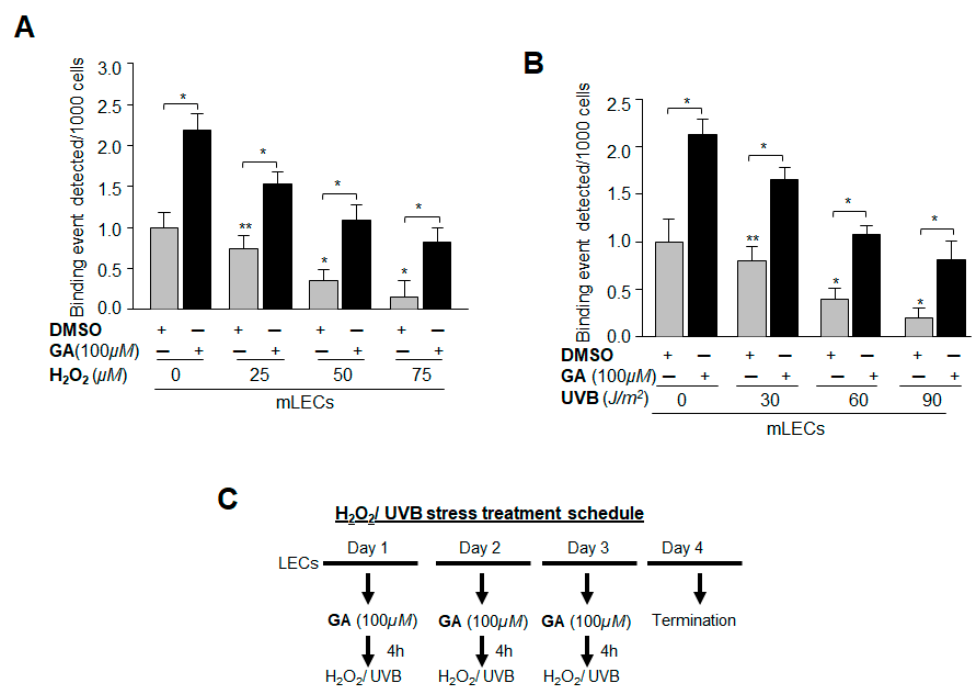
Figure 9. GA significantly promoted Sp1 binding to its element present in Prdx6 promoter by abating oxidative stress and aberrant Sumoylation signaling. ( A , B ) mLECs were treated with Sumoylation inhibitor GA. The cells were washed and exposed 4 h later to different concentrations of H 2 O 2 ( A ) or UVB ( B ) as indicated. Similarly, treatment was repeated on day two and day three. A ChIP assay was carried out 72 h later, using a ChIP grade anti-Sp1 antibody. The DNA fragments were used as templates for qPCR by using a primer designed to amplify − 208 to +27 region of the Prdx6 promoter bearing Sp1 sites. Histogram shows the amplified DNA fragment; gray vs. black bars and untreated samples vs. samples treated with H 2 O 2 /UVB. The data represent mean ± SD from three independent experiments (** p < 0.05; * p < 0.001). ( C ) Represents the treatment schedule.